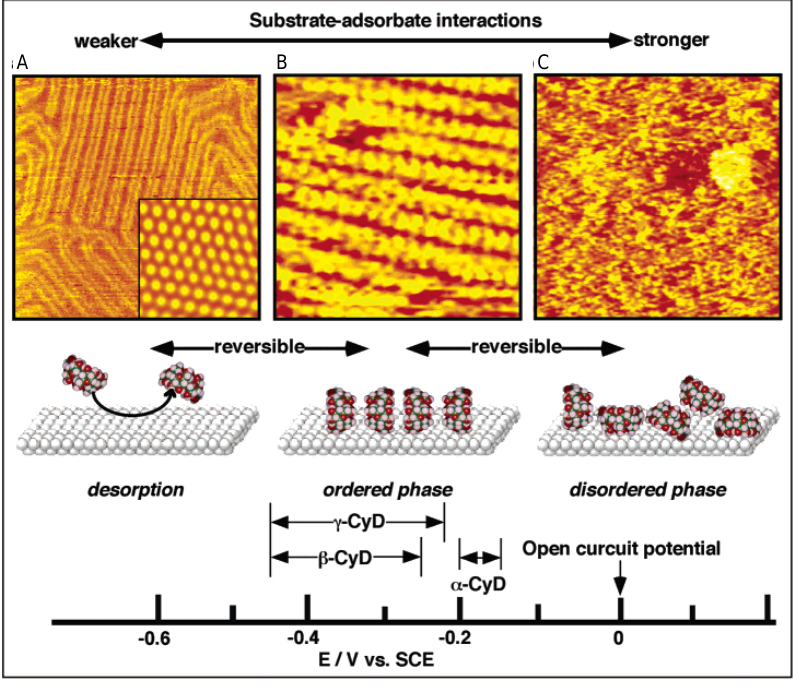
Figure 6. In-situ STM images and a schematic illustration of CyDs at the aqueous solution–Au(111) interface controlled by electrochemical potential. Reprinted with permission from reference [32]. Copyright 2003 American Chemical